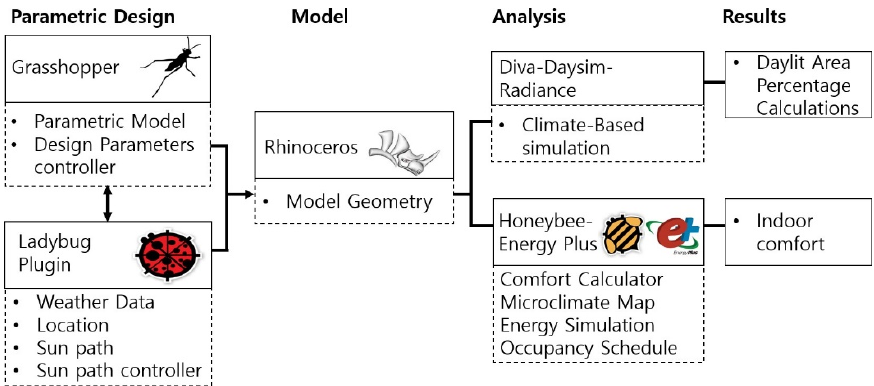
Figure 3. Parametric Design and Simulation Analysis Workflow in this Research.